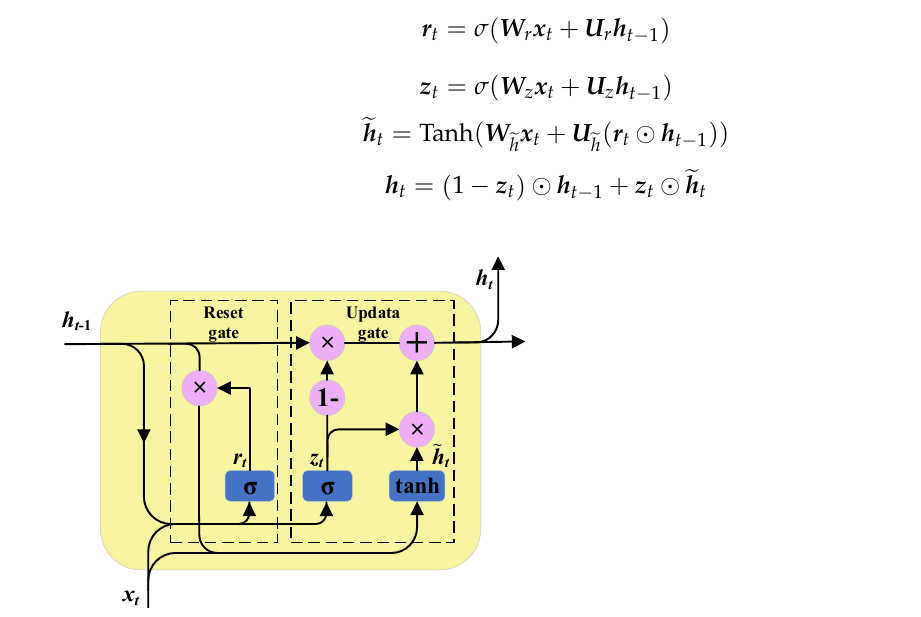
Figure 9. Gated recurrent unit structure.